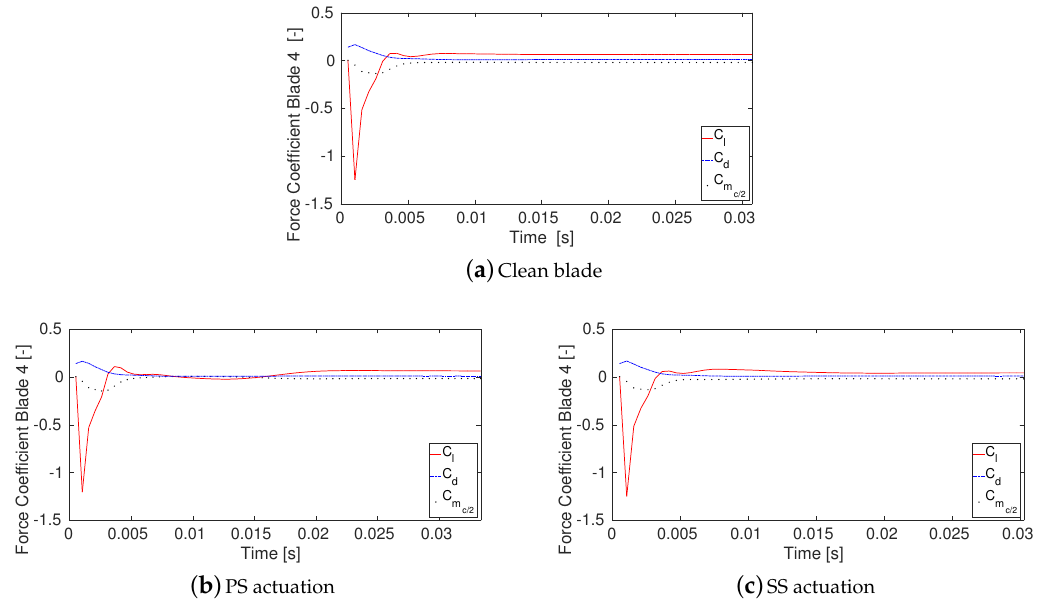
Figure 7. Time history of unsteady lift C l , drag C d and mid-chord moment coefficient C m angle of attack of two degrees; Re ∼